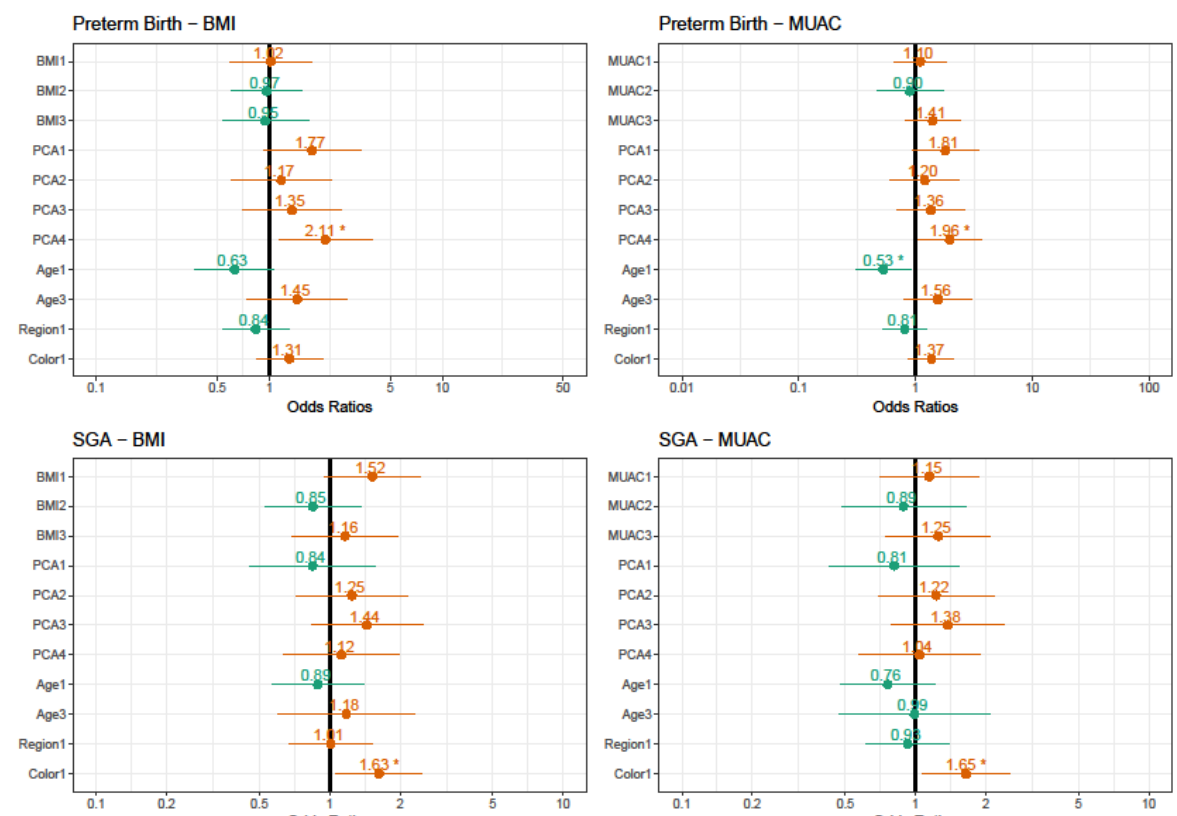
Figure 2. Estimated risks for Preterm-birth and small-for-gestational-age using BMI or MUAC. BMI 1: obese; BMI 2: